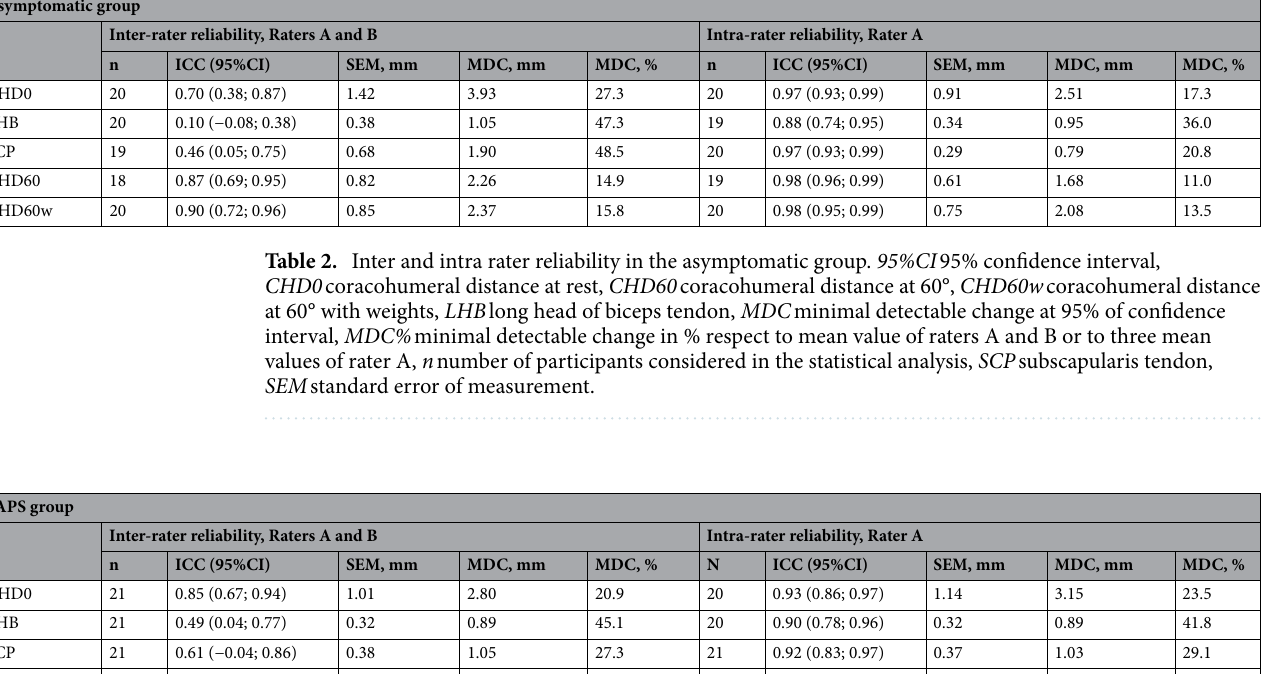
(Table 3). Similarly, intra-rater reliability of rater A was good-to-excellent (0.88–0.97) for LHB and SCP thick- nesses in asymptomatic participants, and it was also good-to-excellent (0.90–0.92) in SAPS. Inter-rater reliability between raters was moderate-to-good (0.70–0.90) for CHD at rest and at 60° of elevation with and without weights in asymptomatic participants (Table 2), and it was good (0.85–0.87) in SAPS (Table 3). Inter-rater reliability for tendons’ thicknesses (LHB, SCP) was poor (0.10–0.46) in asymptomatic participants and poor-to-moderate (0.49–0.61) in SAPS. In general, intra-rater reliability was higher than inter-rater reliability for all US measures, with largest differences in tendons’ thickness. In particular, the inter-rater reliability of tendons’ thickness was lower than measures of CHD at rest or 60° of elevation, with and without weights. The SEM and MDC were lower for intra-rater rather than inter-rater values on all US measures in the asymptomatic group, while in the SAPS group they were lower only in SCP and LHB. The MDC in % followed the same trend of SEM and MDC (in mm) in the asymptomatic group, while in the SAPS group it was lower in intra-rater values compared to inter-rater values only in LHB. The Bland–Altman plots showed differences of less than 0.66 mm between raters for CHD at rest and at 60° of elevation with or without weights, and no systematic or proportional bias were present in both asymptomatic and symptomatic participants (Fig. 6a–f). In contrast, rater A evaluated significantly higher LHB than rater B in both asymptomatic (p < 0.001) and symptomatic groups (p = 0.002), and proportional bias was visible in Bland–Altman plots, where rater A evaluated thicker LHB than rater B for participants with thicker LHB (Fig. 6g,h), confirmed by regression analysis (p < 0.042). No significant differences between raters were present in asymptomatic participants for SCP (Fig. 6i), whereas rater A measured significantly lower values (p < 0.001) in SAPS, but no proportional bias was present (Fig. 6j).